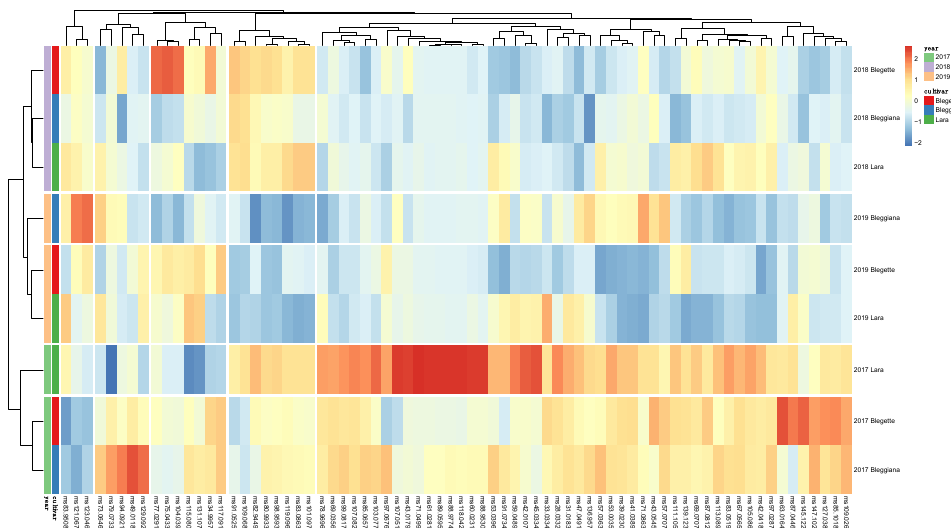
Figure 8. Heat map and two-dimensional hierarchical dendrograms of the VOC profile, assessed by PTR-ToF-MS, of the walnut accessions ‘Bleggiana’, ‘Blegette’ and ‘Lara’, of three harvesting seasons (2017, 2018 and 2019). Cluster analysis was performed using Ward’s method on centered and scaled data. Walnut samples are grouped and clustered by rows, while VOC compounds are organized by columns.